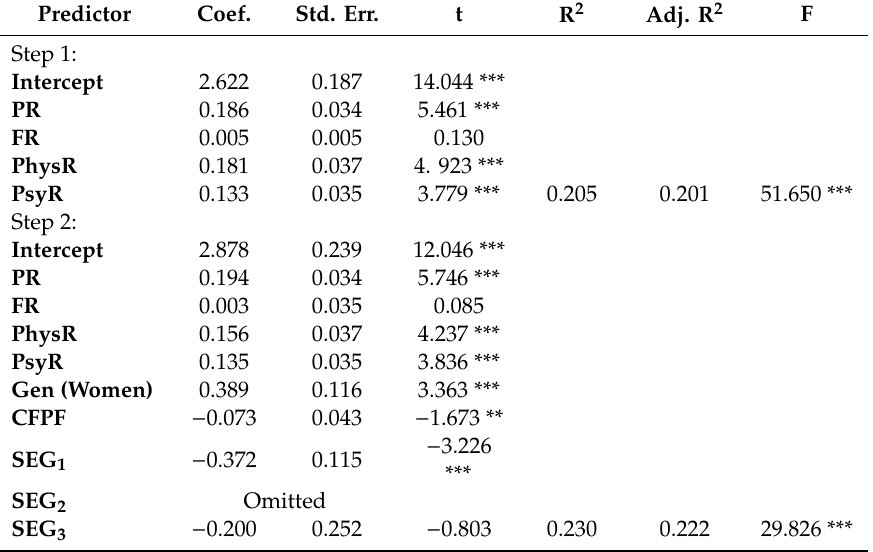
Table 4. Results of the multiple regression model performed on an intention to avoid buying processed foods with